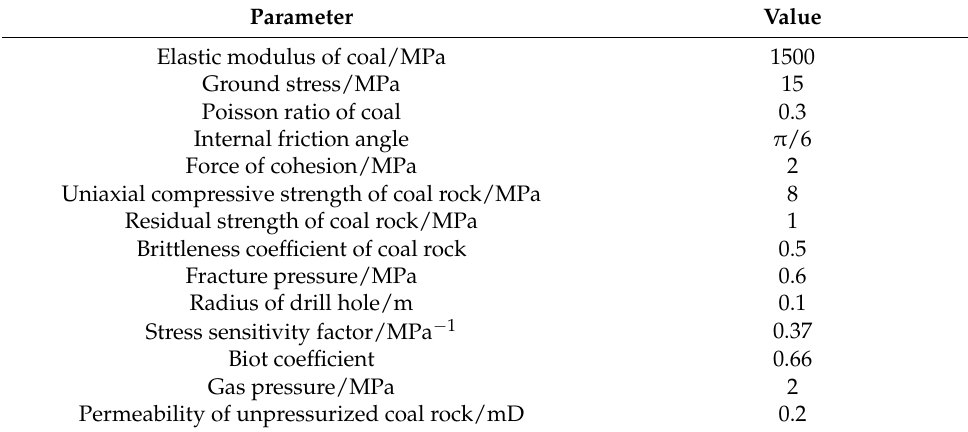
Table 1. Basic parameters of coal and gas.